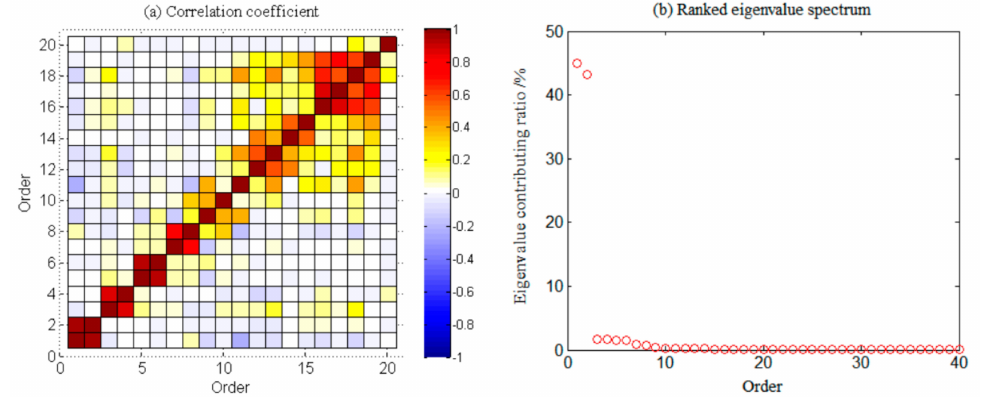
Figure 3. W-correlation analysis of TWSA in Southwest China.